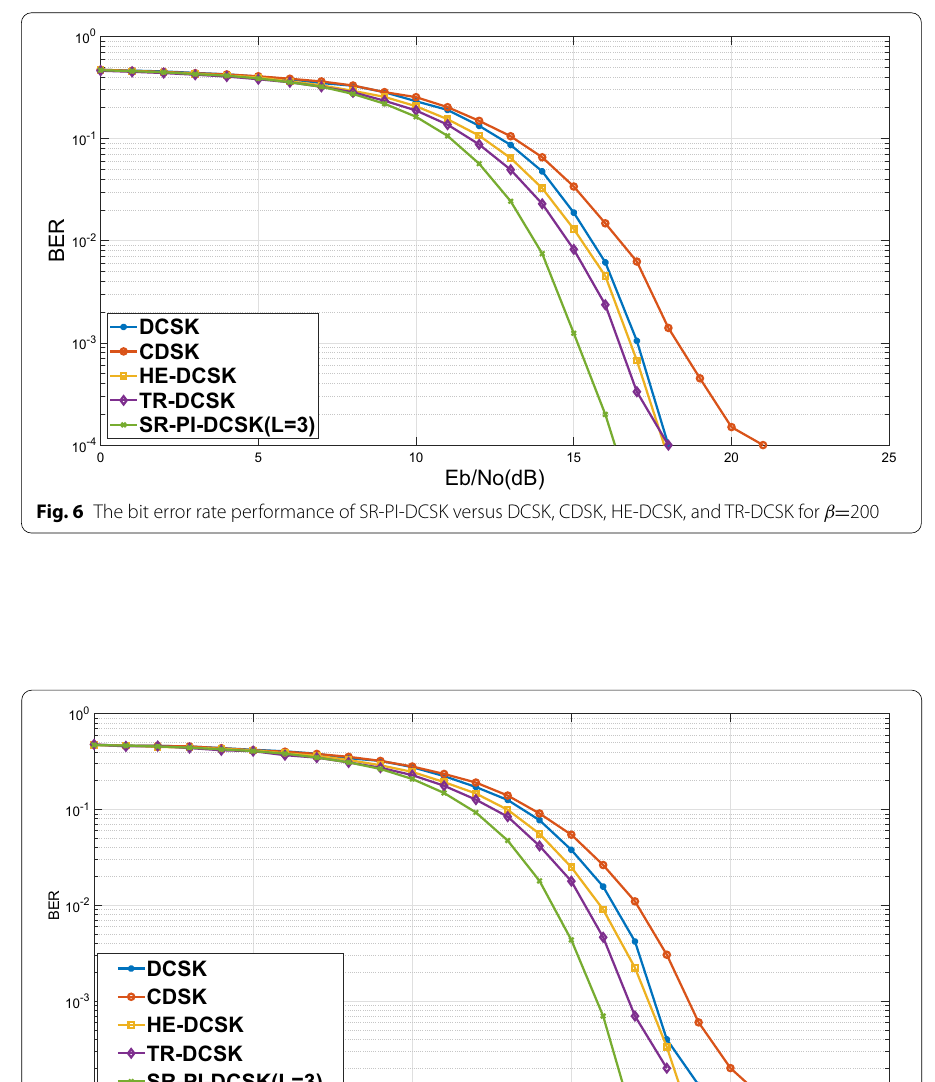
Fig. 7 The bit error rate performance of SR‑PI‑DCSK versus DCSK, CDSK, HE‑DCSK, and TR‑DCSK for β